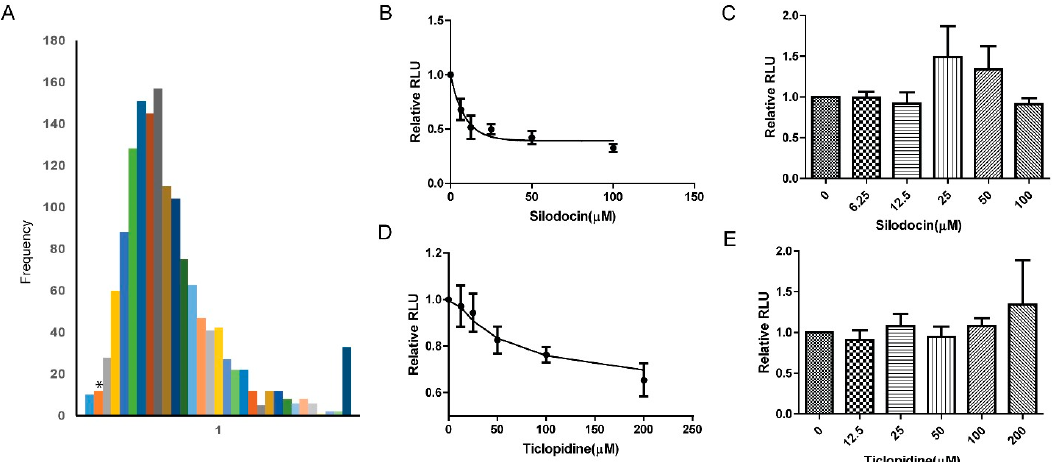
Figure 4. C-P4H1 inhibitors are identified with the high-throughput screening assay from the FDA-approved drug library. ( A ) The frequency for relative activity of P4H1 at the presence of each chemical. Over 1400 FDA-approved drugs were screening in the 384 well plate or 96-well plate at 50 µM. 50 µM DHB was used as a positive control in each plate. All the ATP signals produced by the plate reader were normalized with the equation: relative activity = value of samples with chemicals value of control sample without chemicals . *, the relative activity of C-P4H1 in the presence of DHB. ( B ) Silodocin inhibitory activity was analyzed at different concentrations. All the ATP signals produced by the plate reader were normalized to vehicle control, control value is 1; n = 3. ( C ) Silodocin did not inhibit the Succinate-GloTM Hydroxylase assay in the absence of WT-P4H1; n = 3. ( D ) Ticlopidine inhibitory activity was analyzed at different concentrations; 200 nM C-P4H1 in the reaction. The C-P4H1 activities in ticlopidine-treated samples were normalized with vehicle control, control value is 1; n = 3. ( E ) Ticlopidine did not inhibit the Succinate-GloTM Hydroxylase assay in the absence of WT-P4H1; n = 3. The data displayed as means ± standard deviation (SD).